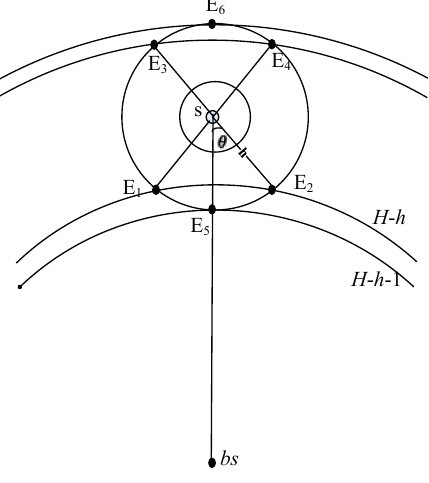
Figure 3. The phantom locations